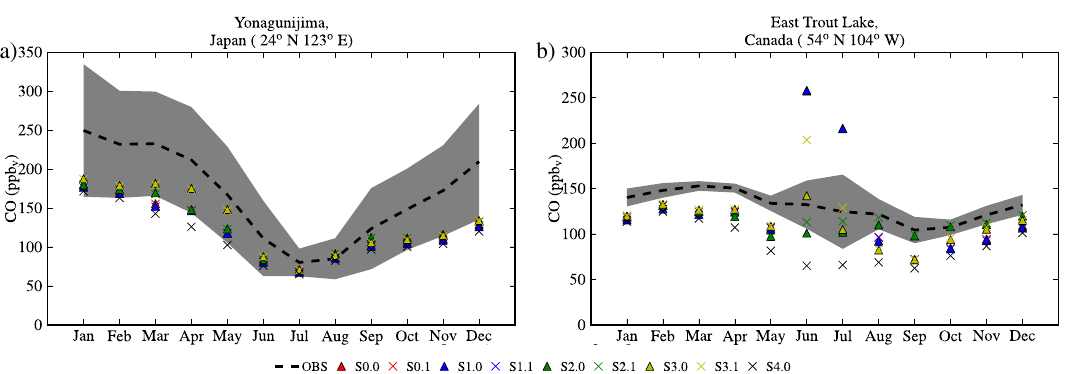
Figure 3. Comparison of monthly mean model results with CO surface observations at Yonagunijima, Japan (a) , and at East Trout Lake, Canada (b) . Lines and symbols as in Fig. 2 but for